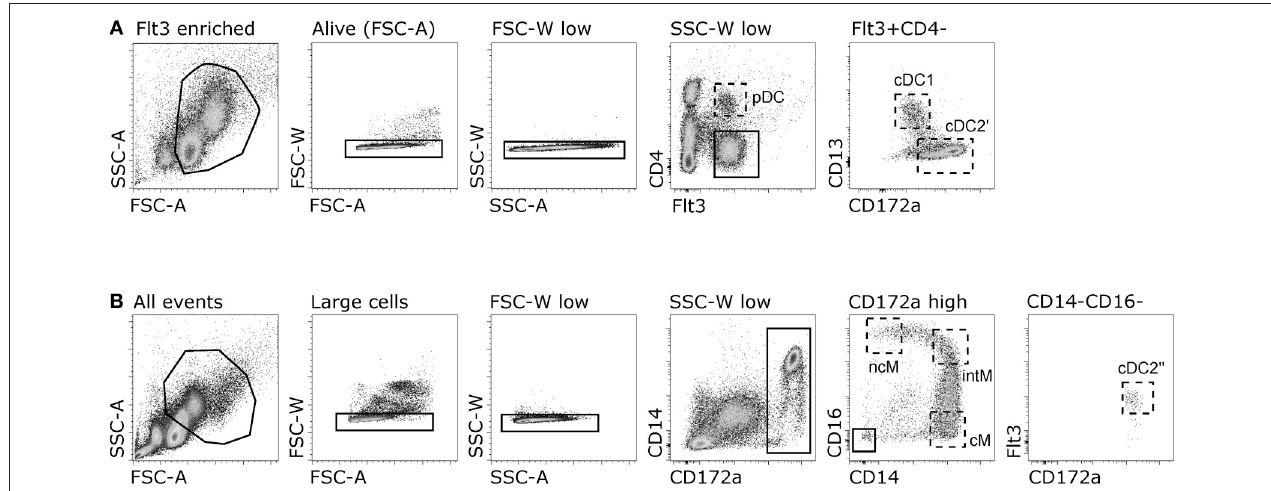
FIGURE 2 | Gating strategy for sorting of DC and monocyte subsets. (A) Sorting of putative DC subsets. Flt3-enriched PBMC were gated for expression of Flt3 and CD4 (putative pDC), and Flt3 + CD4 − cells were further gated as CD13 + (putative cDC1) and CD172a + CD13 − (putative cDC2 ′ ). (B) Sorting of monocyte subsets and putative cDC2. Whole PBMC were gated for large single cells expressing CD172a and monocyte subsets were gated as CD14 + CD16 − (cM), CD14 + CD16 + (intM), and CD14 − CD16 + (ncM). Putative cDC2 ′′ were gated as Flt3 + within the CD14 − CD16 − gate.